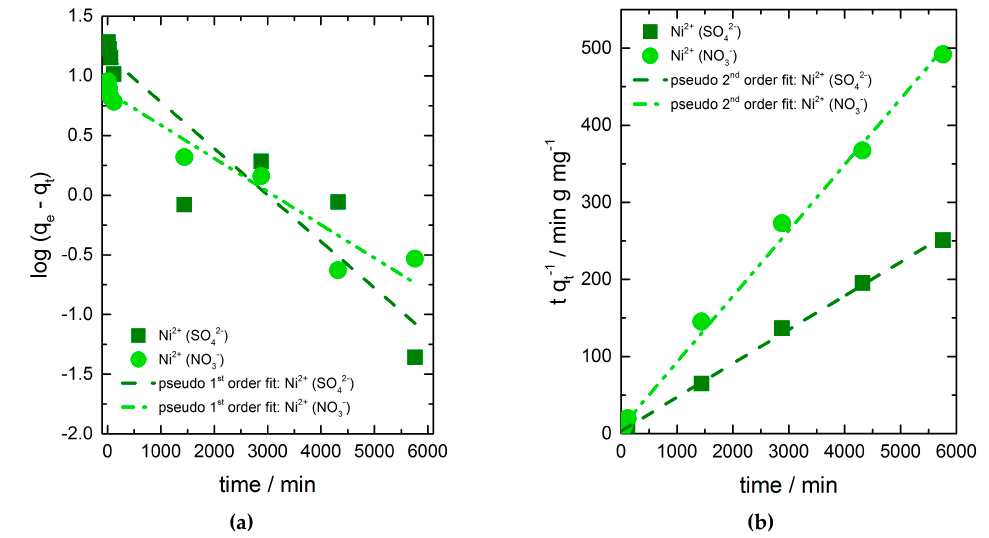
Figure 4. Effect of contact time and the present salt anion on the adsorption of nickel ions on chitosan flakes. Data fits to ( a ) pseudo-first-order and ( b ) pseudo-second-order kinetic model. Table 2. Kinetic parameters determined from pseudo-first-order and pseudo-second-order model of nickel adsorption on chitosan in dependence on salt anion presented in solution.